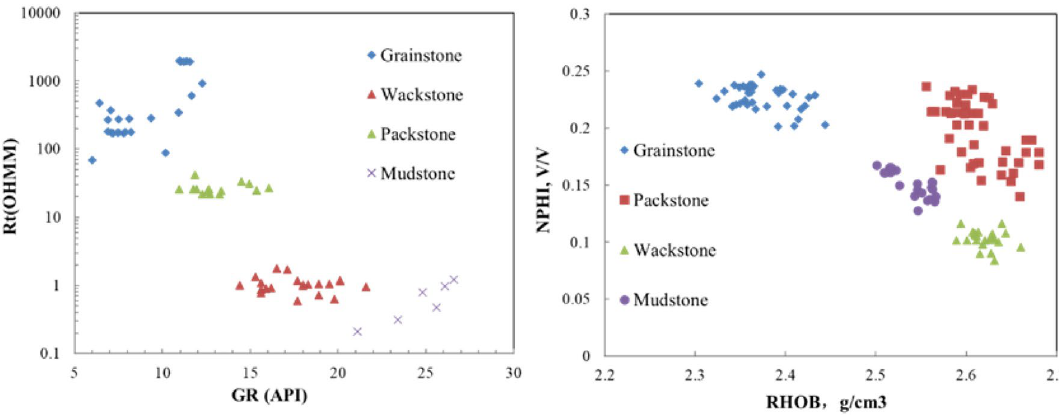
Figure 5. Cross plot of resistivity against natural gamma, neutron against